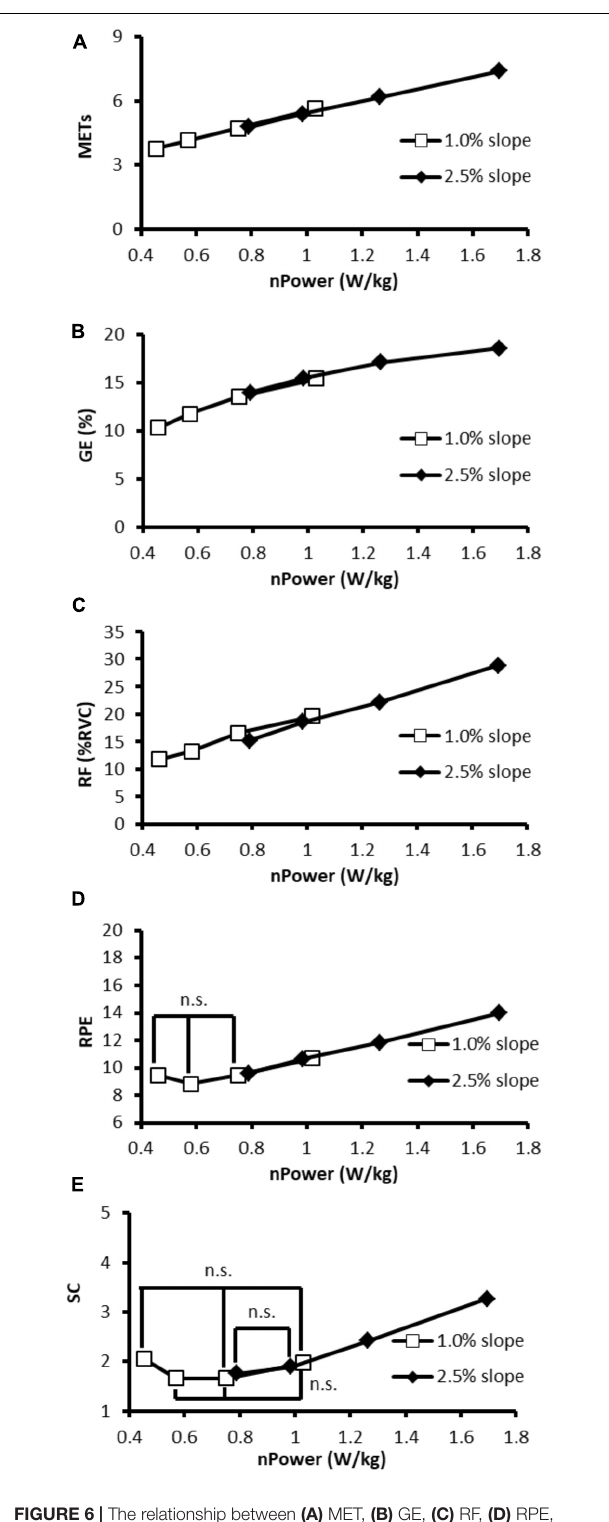
FIGURE 6 | The relationship between (A) MET, (B) GE, (C) RF, (D) RPE, (E) SC, and the normalized power output. Data from heavy and light gear ratios are averaged. Pairwise differences existed between assistive levels except for the non-significant (n.s.) marked conditions. nHR, VL, and VM were omitted due to the similar patterns were